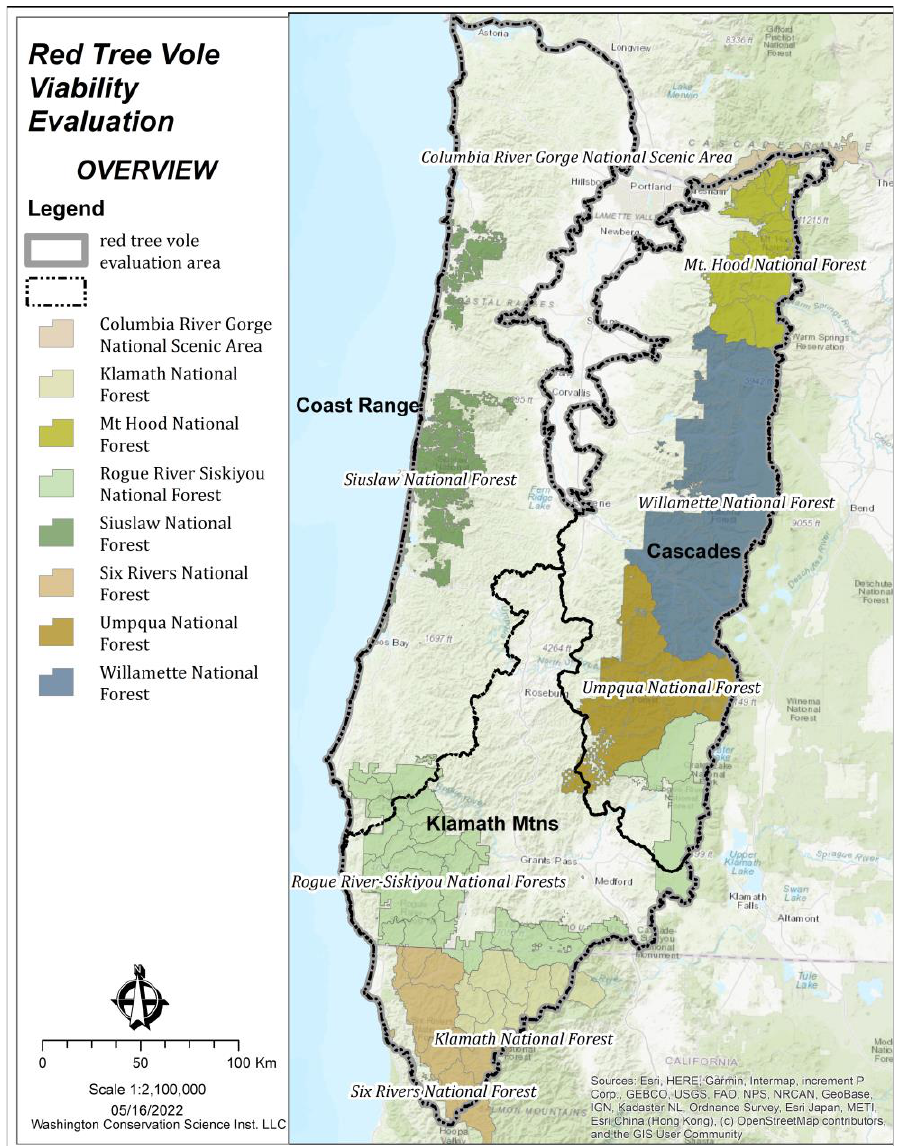
Figure 1. Evaluation area, ecoregions, and national forests located within the range of the red tree vole ( Arborimus longicaudus ) in Oregon and California, USA.